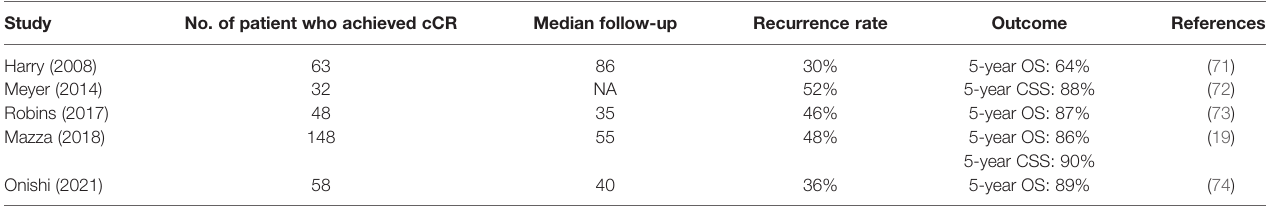
cCR, complete clinical response; OS, overall survival; CSS, cancer-speci fi c